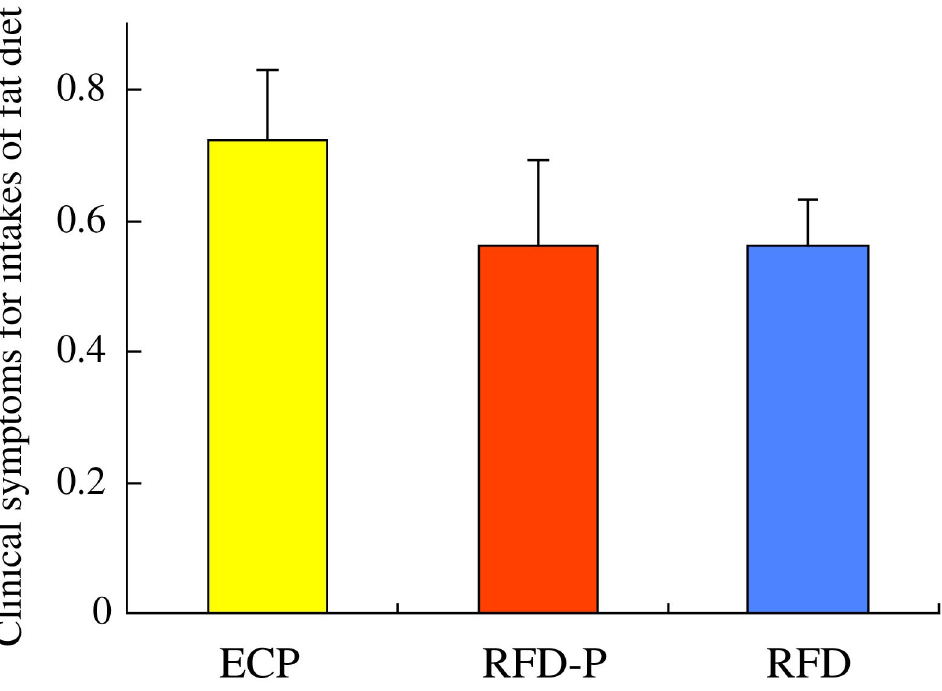
Fig 4. Comparison of clinical symptoms for fat intake among each group. Score of clinical symptoms (0.72 ± 0.11) for fat intake in early chronic pancreatitis (ECP) patients did not significantly differ from those (0.56 ± 0.13, 0.56 ± 0.07) in anti-acid therapy-resistant FD patients with pancreatic enzyme abnormalities (RFD-P) and anti-acid therapy-resistant FD patients (RFD).